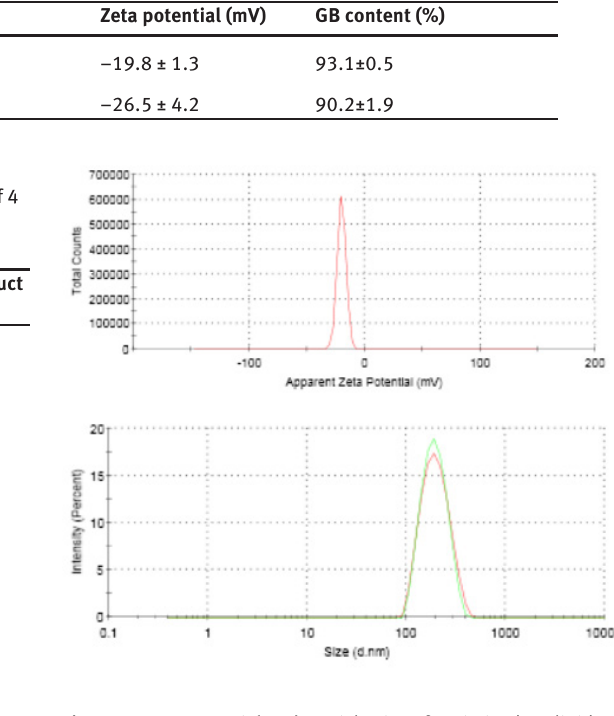
Figure 2 : Zeta potential and particle size of optimized GB lipid emulsion. Each value represents the average ±S.D. (n=3 )